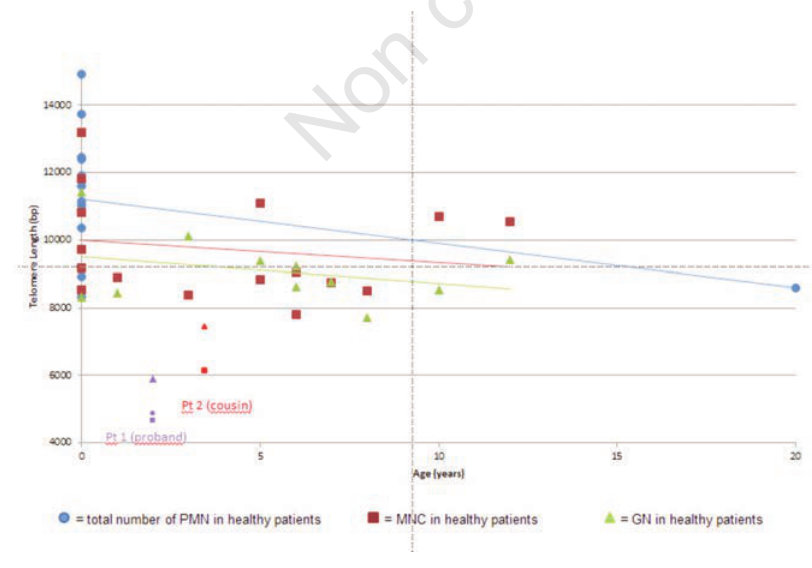
Figure 2. Telomere length in the patients (proband and cousin) and controls (healthy patients). Pt= patient; PMN= Polymorphonuclear leucocytes; MNC= Mononuclear cells; GN= Neutrophil